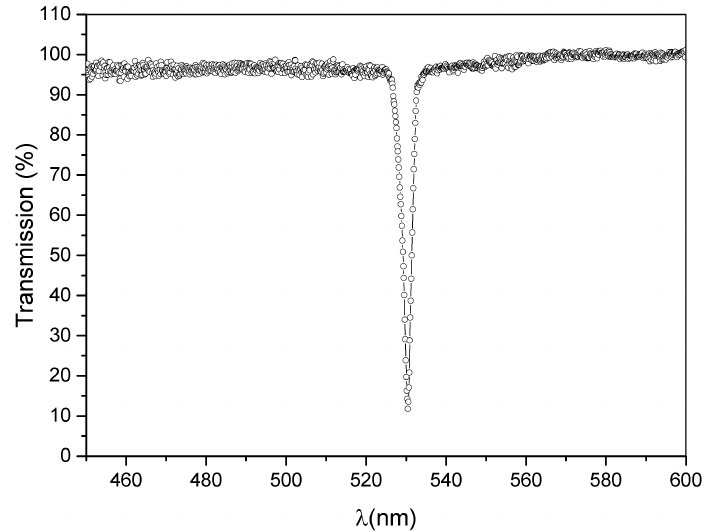
Figure 3. High efficiency transmission spectrum recorded in our holographic mixture. Recording power P = 100 mW per beam, λ = 457.9 nm, grating pitch Λ = 170 nm.